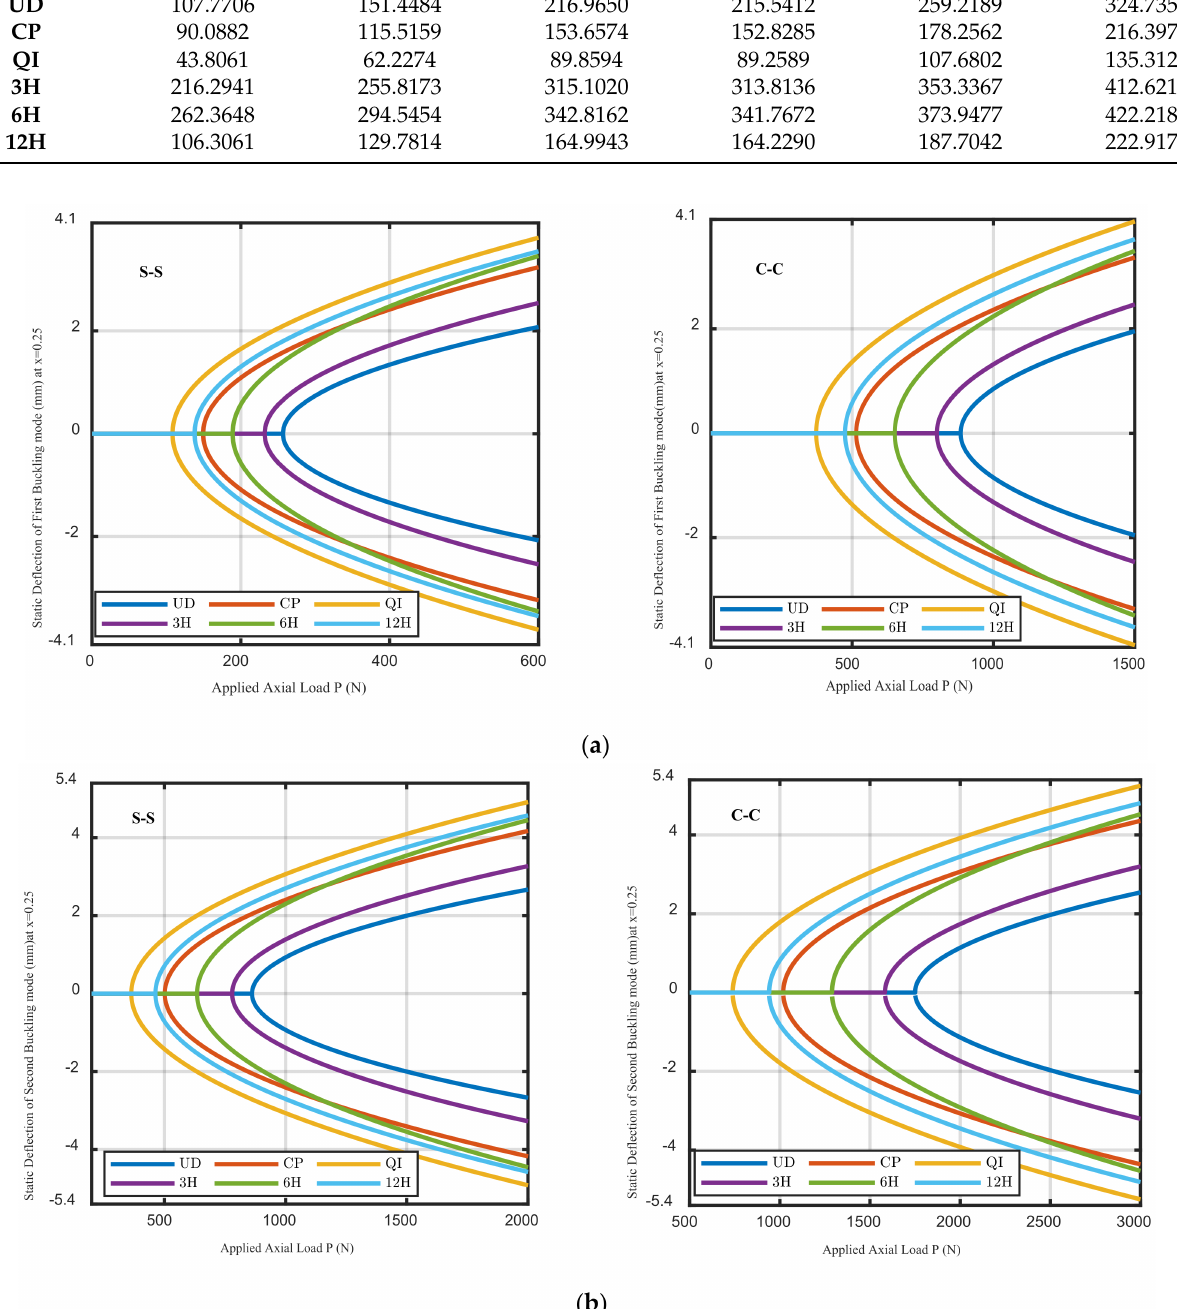
Figure 6. Load-deflection response of S–S and C–C perfect composite beams related to first and second postbuckling mode with different layup configurations. ( k L = 20, k s = 0, L = 100 h ). ( a ) 1st buckling mode. ( b ) 2nd buckling